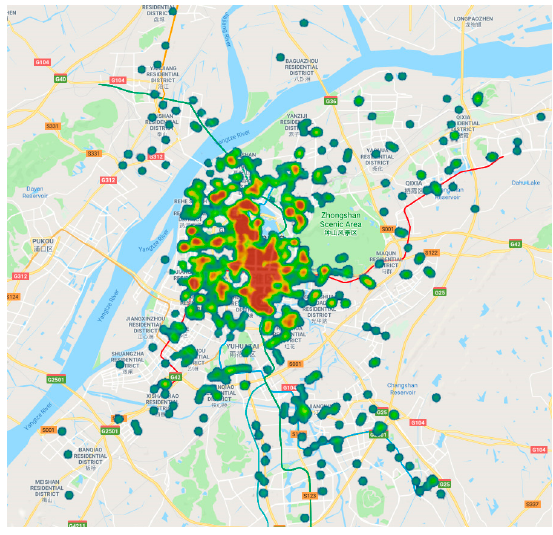
Figure 8. Spatial distribution of FFBS on week days.